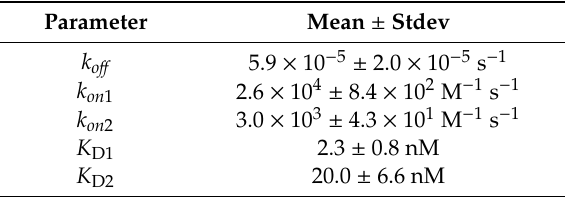
Table 1. Parameters of RSA interaction with immobilized Lst-ABD Parameter